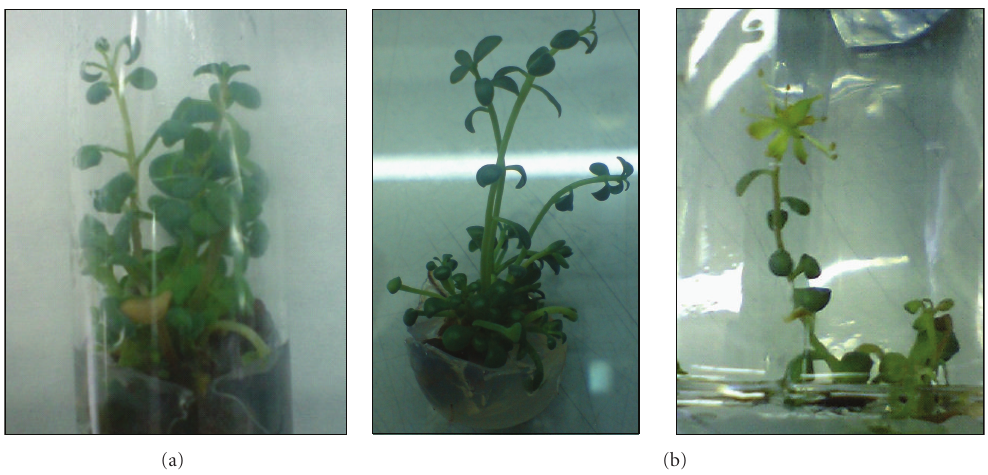
Figure 3: Rh. rosea plant regeneration from in vitro seedling leaf nodes (a); shoot multiplication (b) and flowering regenerant on MS basal medium enriched with 2mg/L zeatin, 0.2 mg/L IAA, and 1000 mg/L casein hydrolysate.